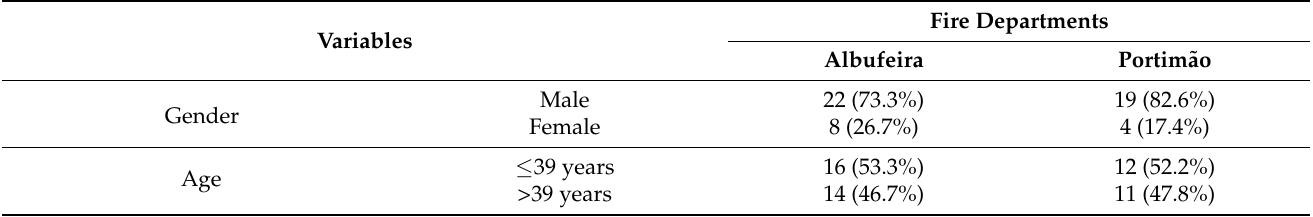
Table 5. Relationship between the variables and the fire departments of Albufeira and Portim ã